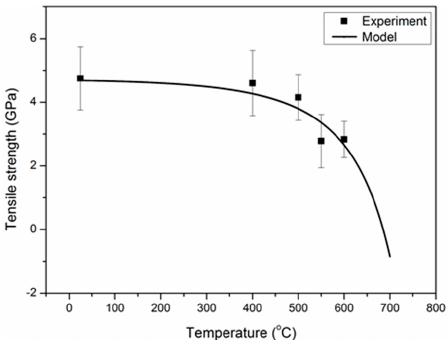
Figure 20. The dependence of the exposure temperature on the tensile strength .